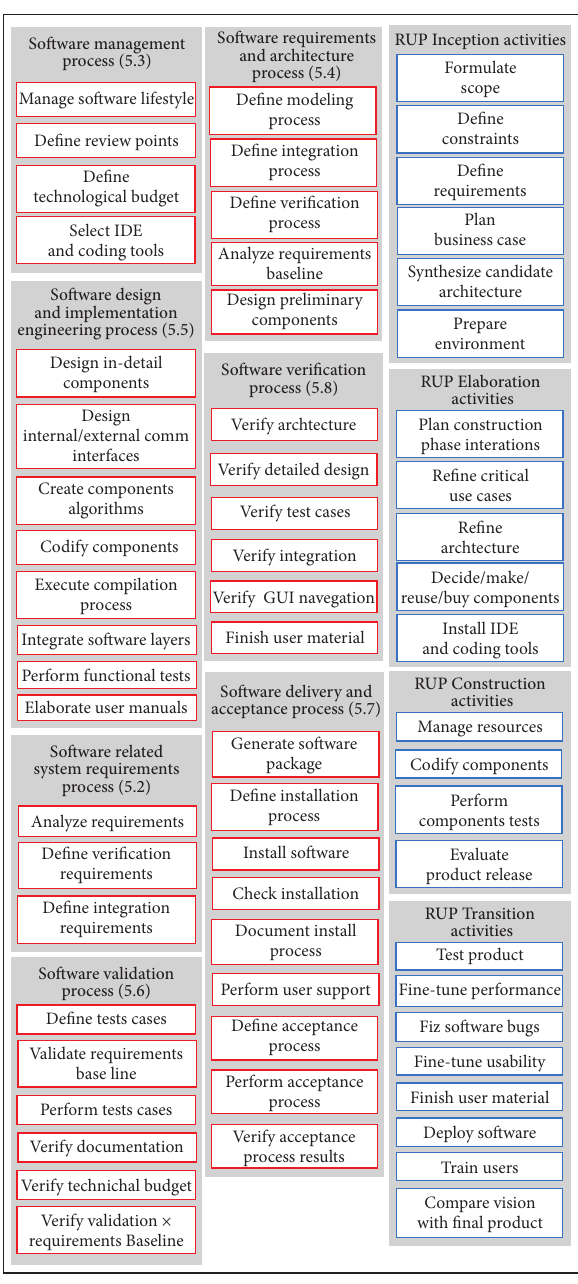
figure 4. Activities proposed by ECSS-E-ST-40C and